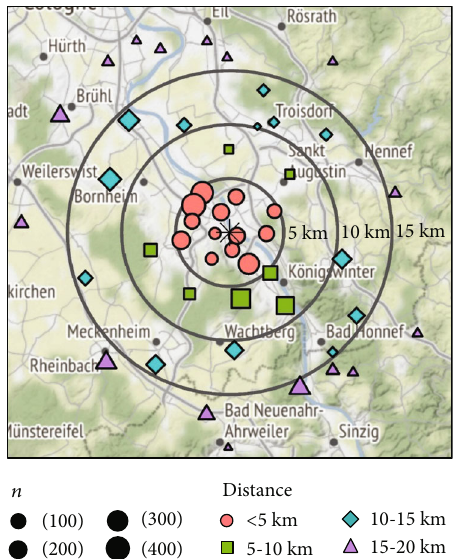
Figure 1: Number of patients per zip code area and distance to pediatric ED ( ∗ ) in the year 2017 (Map tiles by Stamen Design, under CC BY 3.0. Data by OpenStreetMap, under